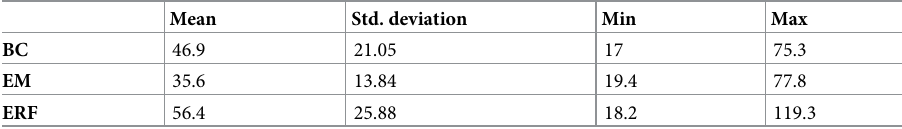
Table 3. Precision values ( μ m) for all stone models.